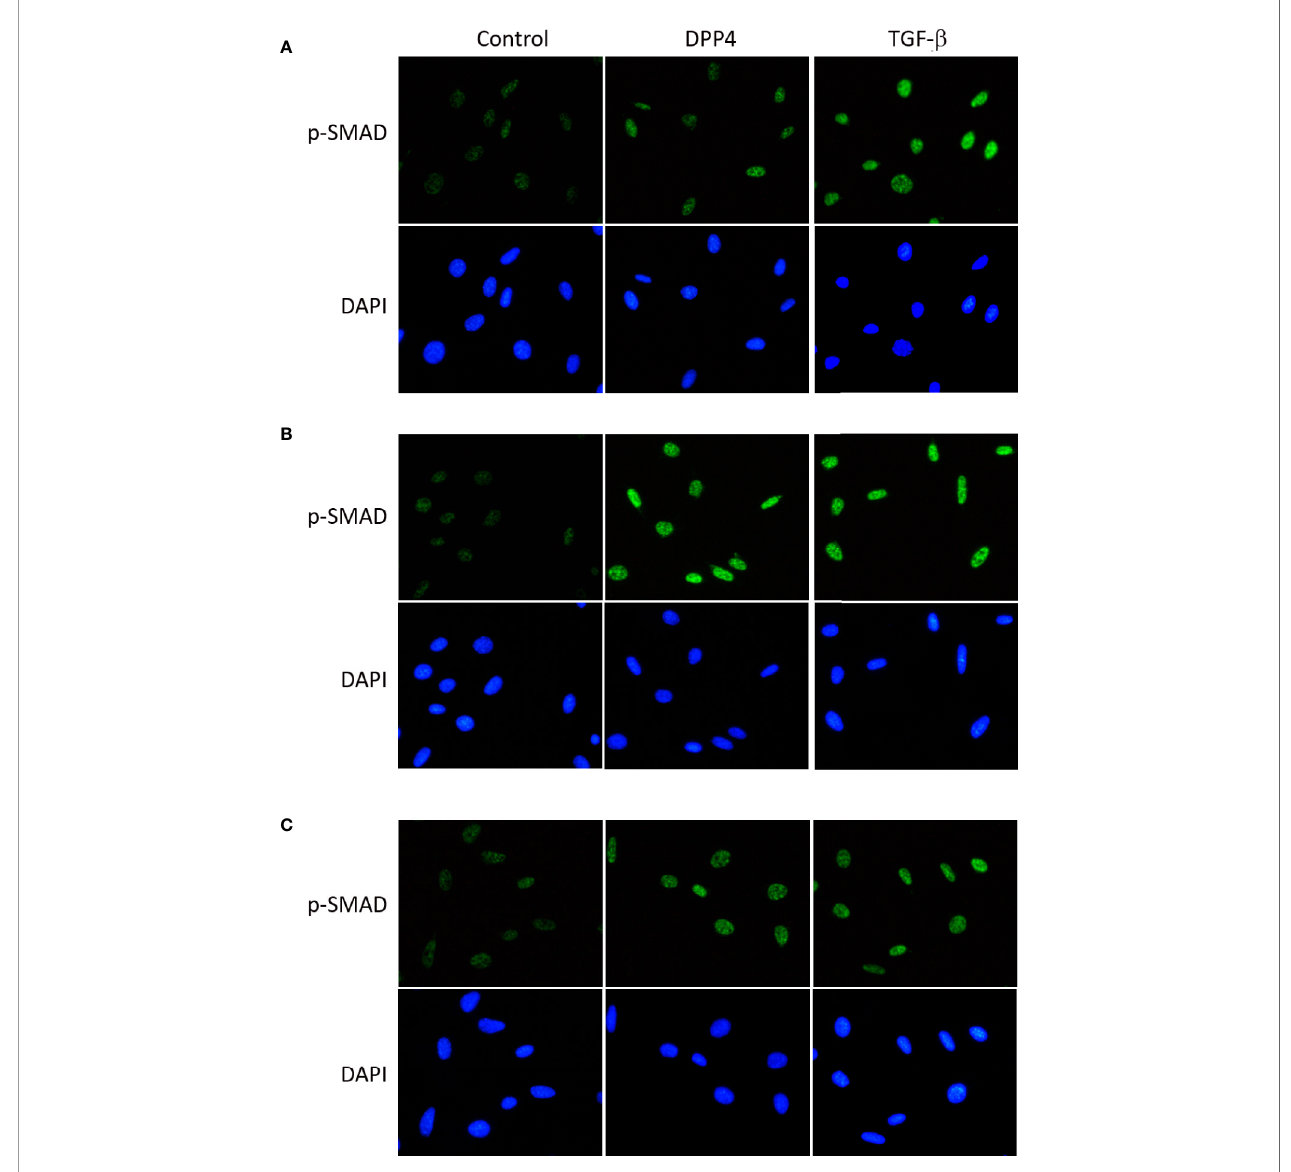
FIGURE 6 | Effects of DPP4 on p-SMAD activation in human dermal fi broblast. Human dermal fi broblast were treated with recombinant DPP4 (200 ng/mL) or TGF- b (10g/mL). Immuno fl uorescent staining of p-SMAD was determined after (A) 6 h, (B) 24 h, and (C) 48 h of DPP4 or TGF- b